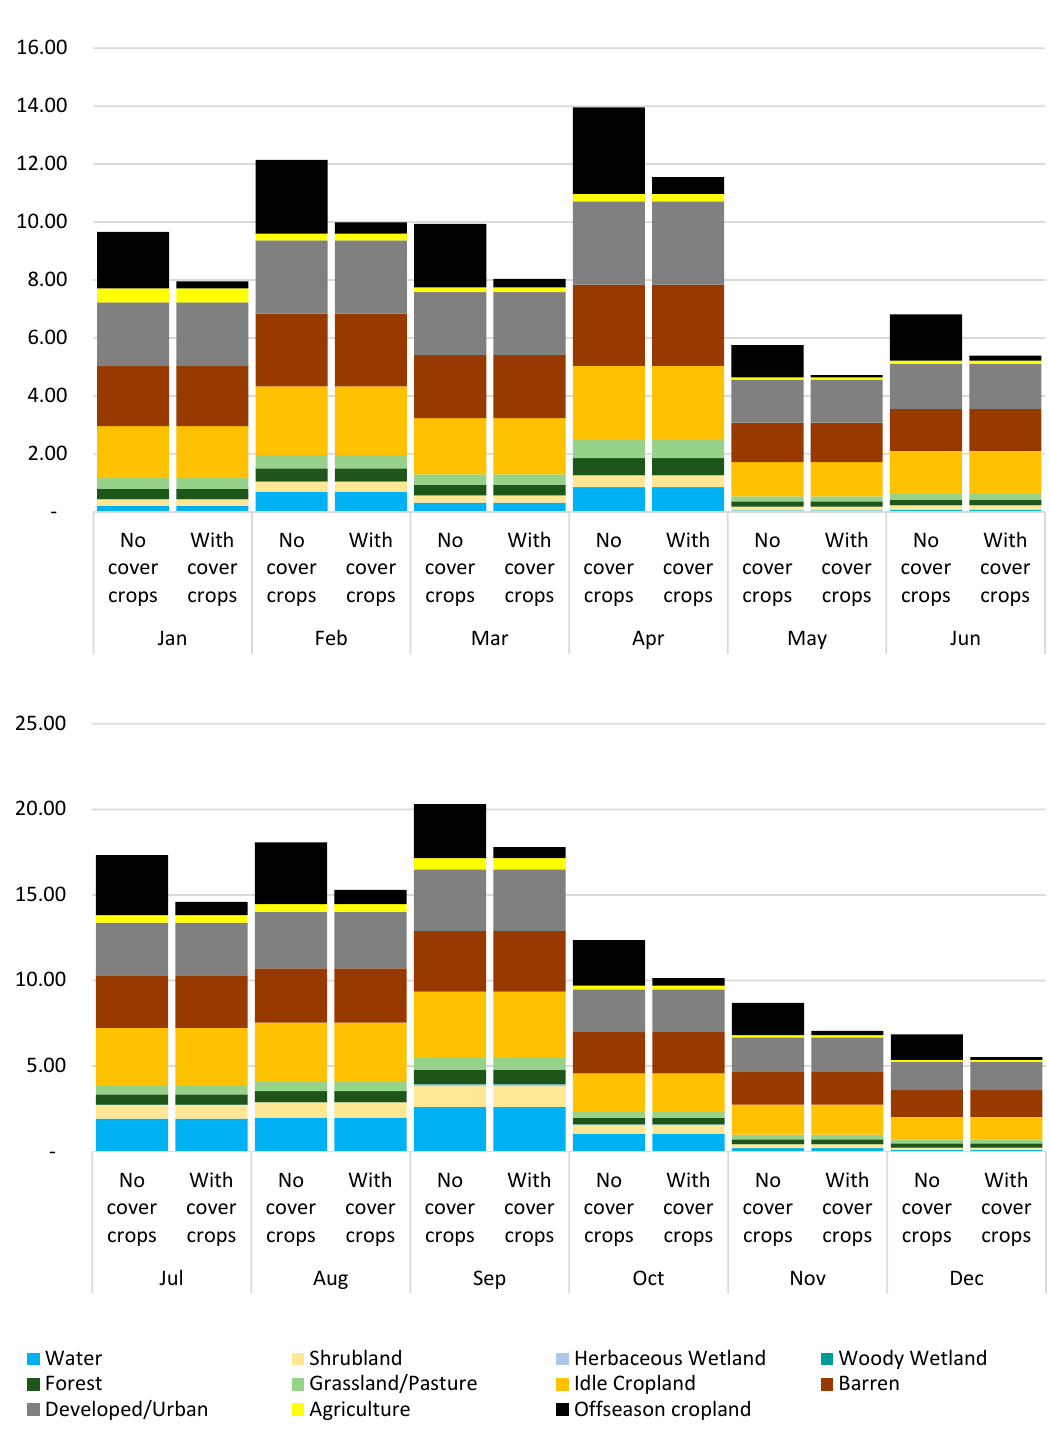
Figure 10. Results showed that the monthly mean water yield potential in meters per square meter with and without cover crops varied per month.